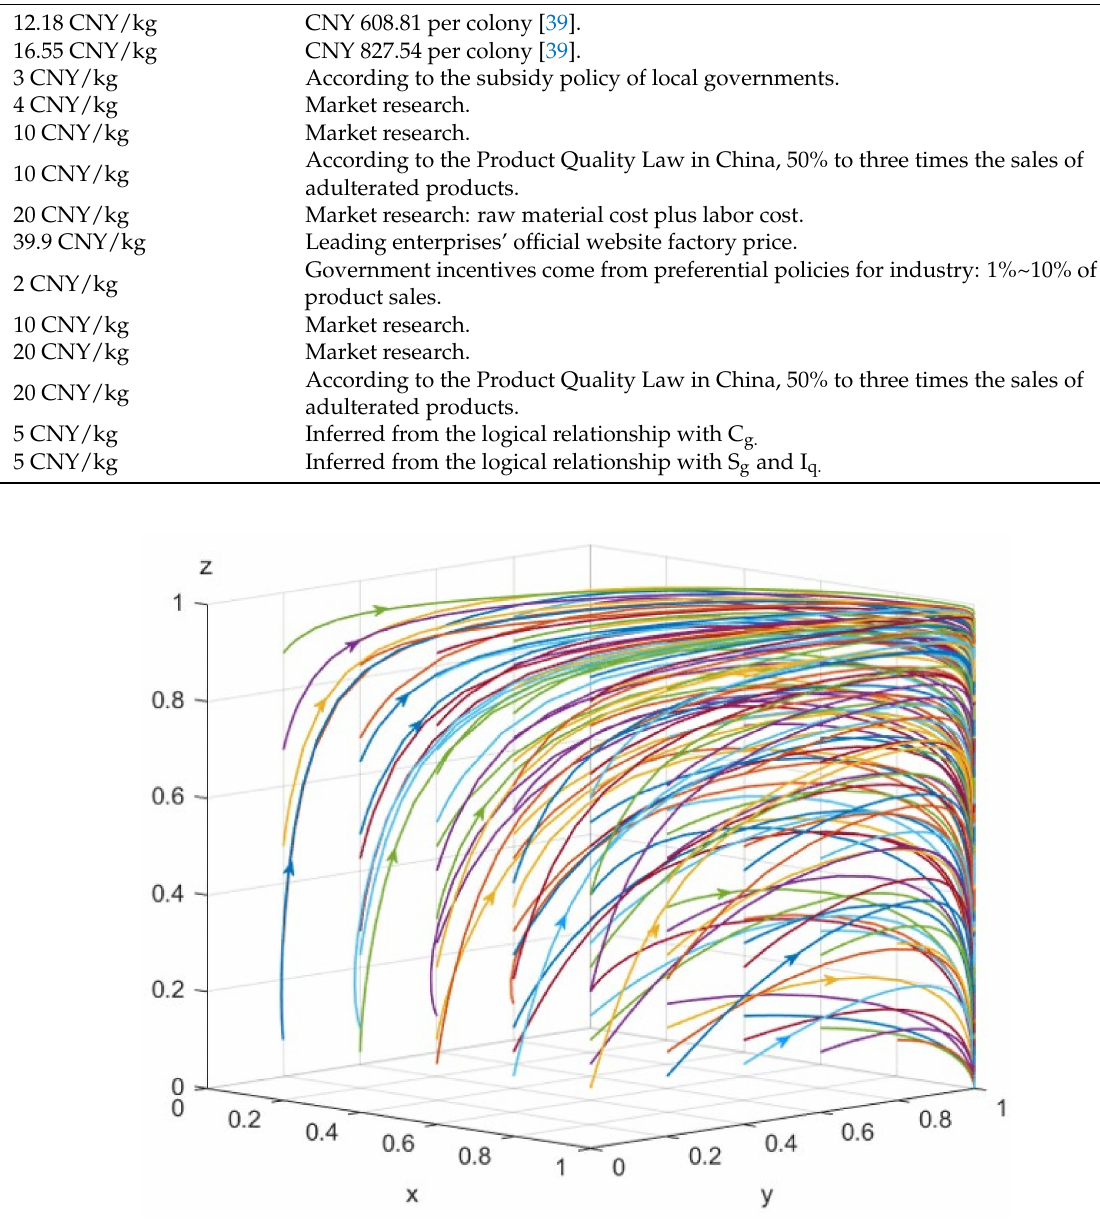
Figure 3. The phase diagram of different stakeholders with initial parameters (Lines of different colors represent evolutionary paths generated from different starting